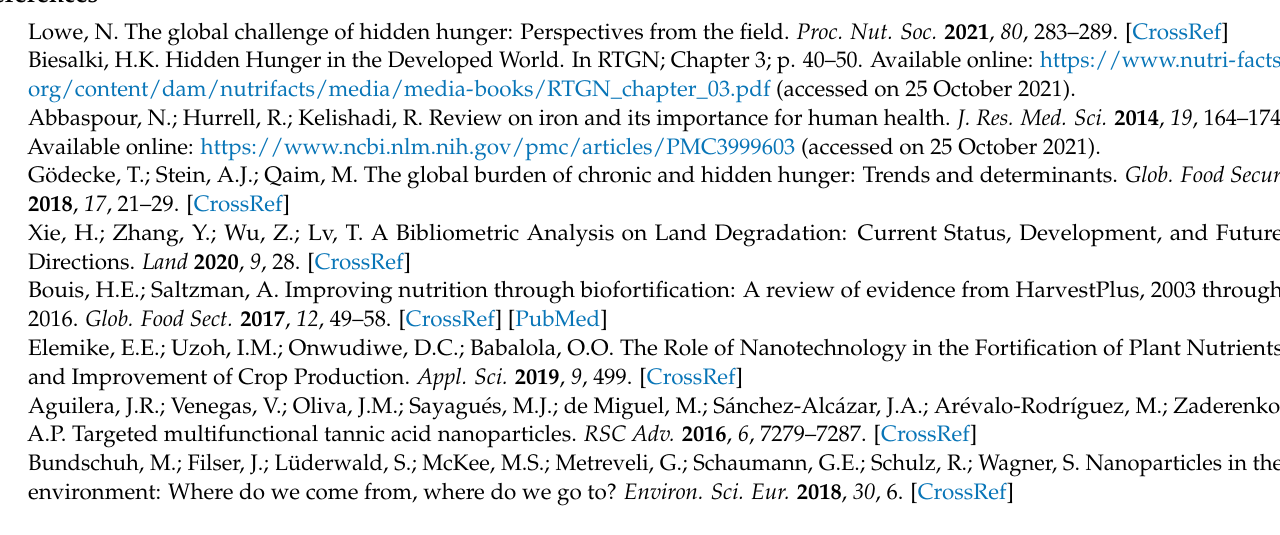
Supplementary Information Figure S2: Scheme of the microtiter plate for determination of the CMI of the bacterium B. aryabhattai RSO25 towards the FeNPs nanoparticles. A: TSB; B: TSB + 20% FeNPs; C: TSB + 10% FeNPs; D: TSB + 5% FeNPs; E: TSB + 2.5% NPs of FeNPs; F: TSB + 1.25% FeNPs; G: TSB + 0.625% FeNPs; H: TSB + 0.3125%